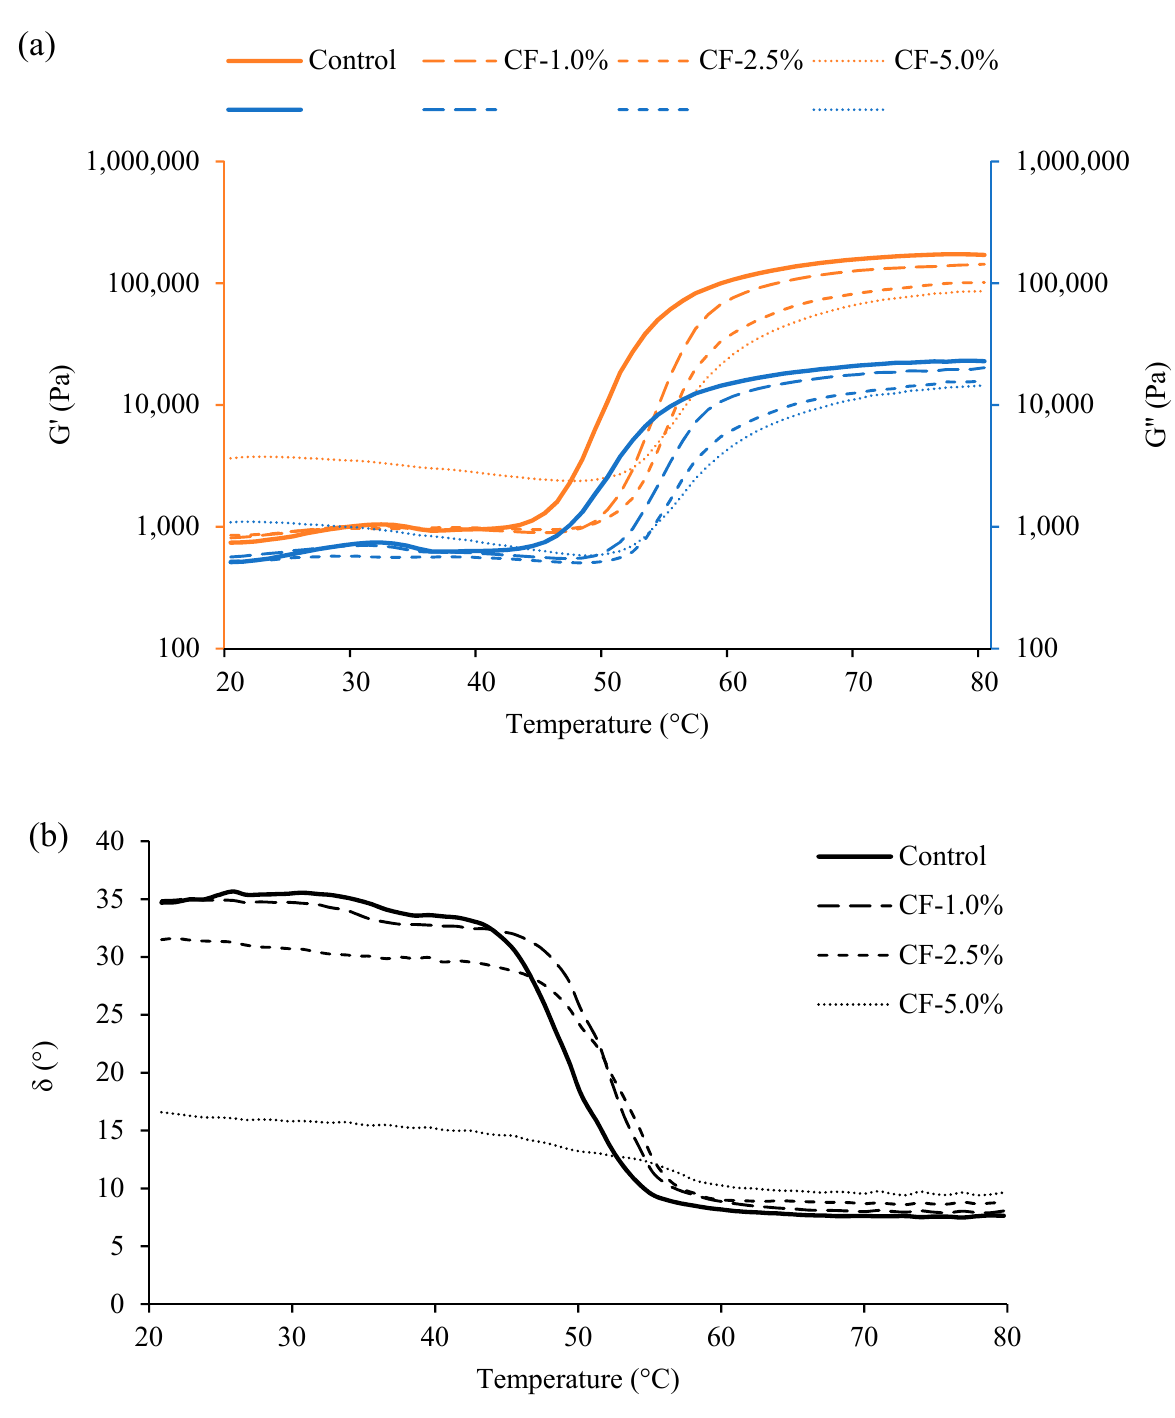
Figure 2. Rheological measurements ( a ) G (cid:48) (the storage modulus) and G” (loss modulus), ( b ) δ (phase angle) of raw sausage batter formulated with lean pork, pork fat, and cricket flour when subjected to heating (20–80 ◦ C). Control sausages are formulated with lean pork, pork fat, salt, phosphate, and ice water; CF sausages are hybrid sausages formulated by adding CF at 1% (CF-1.0%), 2.5% (CF-2.5%), and 5.0% (CF-5.0%) levels to the base (control) recipe.